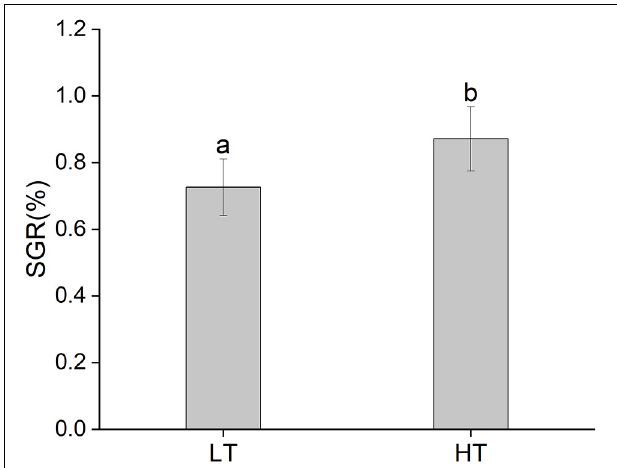
FIGURE 3 | Incidence of vertebral fusion of juvenile T. ovatus (LT, low temperature group; HT, high temperature group).